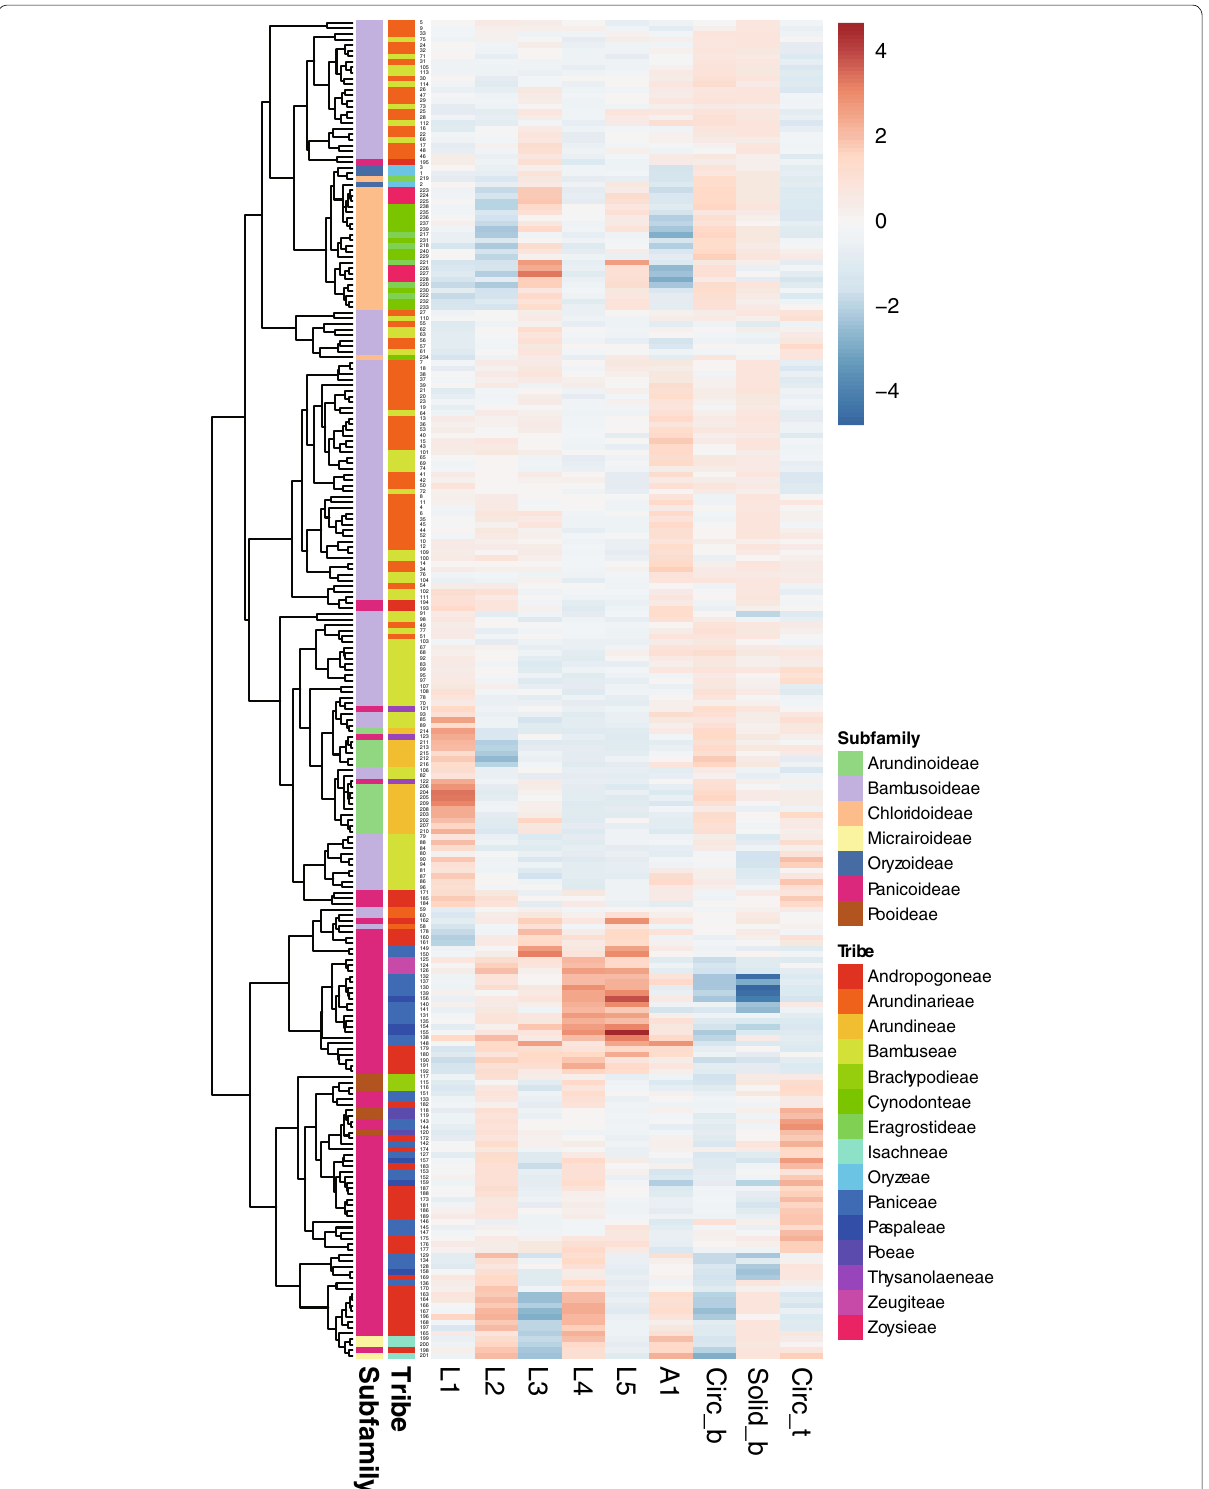
Fig. 4 Cluster diagram and heat map of shape parameters from the analysis including all measured samples in Poaceae. The numbers are identical to the sample numbers in Table